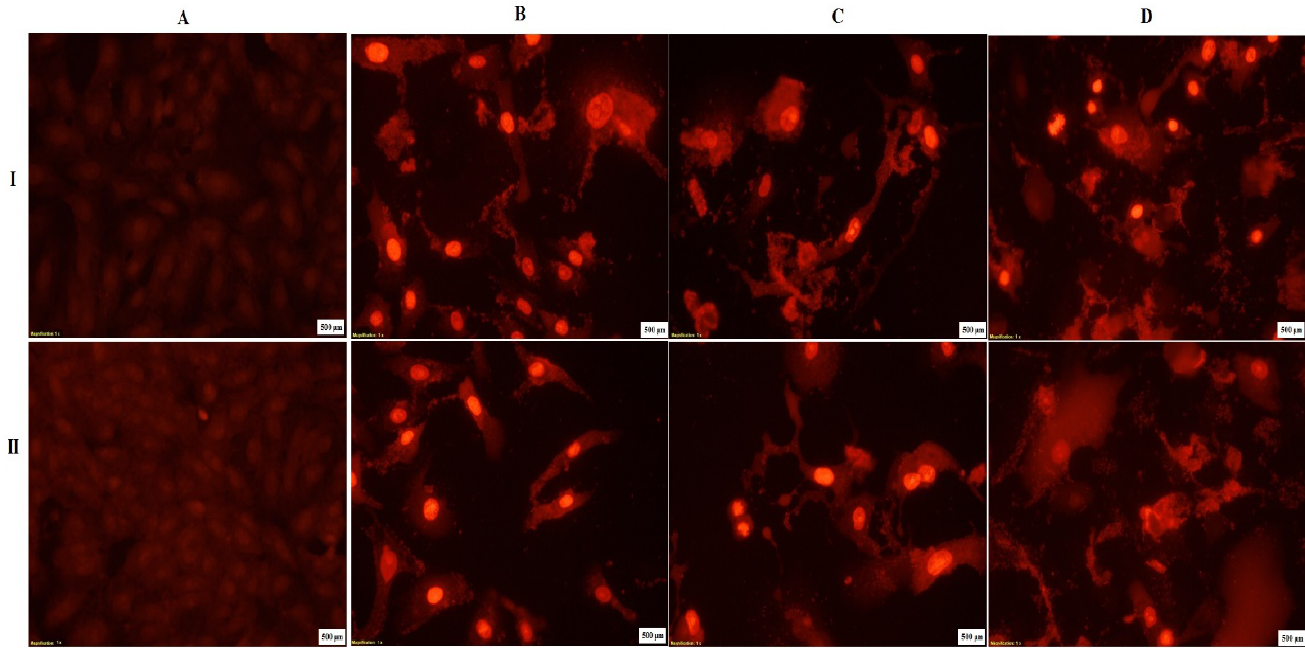
Figure 5. The dependence inhibition effect of the modified WO 3 NPs on the cell viability of the normal WISH cells ( A ), breast cancer MCF-7 cells ( B ), colon cancer Caco-2 cells ( C ), and hepatoma HepG-2 cells ( D ). Both normal cells and cancer cell lines were incubated with the WO 3 -AAs NPs at different concentrations (0–0.5 mg/mL) for 48 h. All values are expressed as mean ± SE and represent the average values from three experiments ( n = 3).